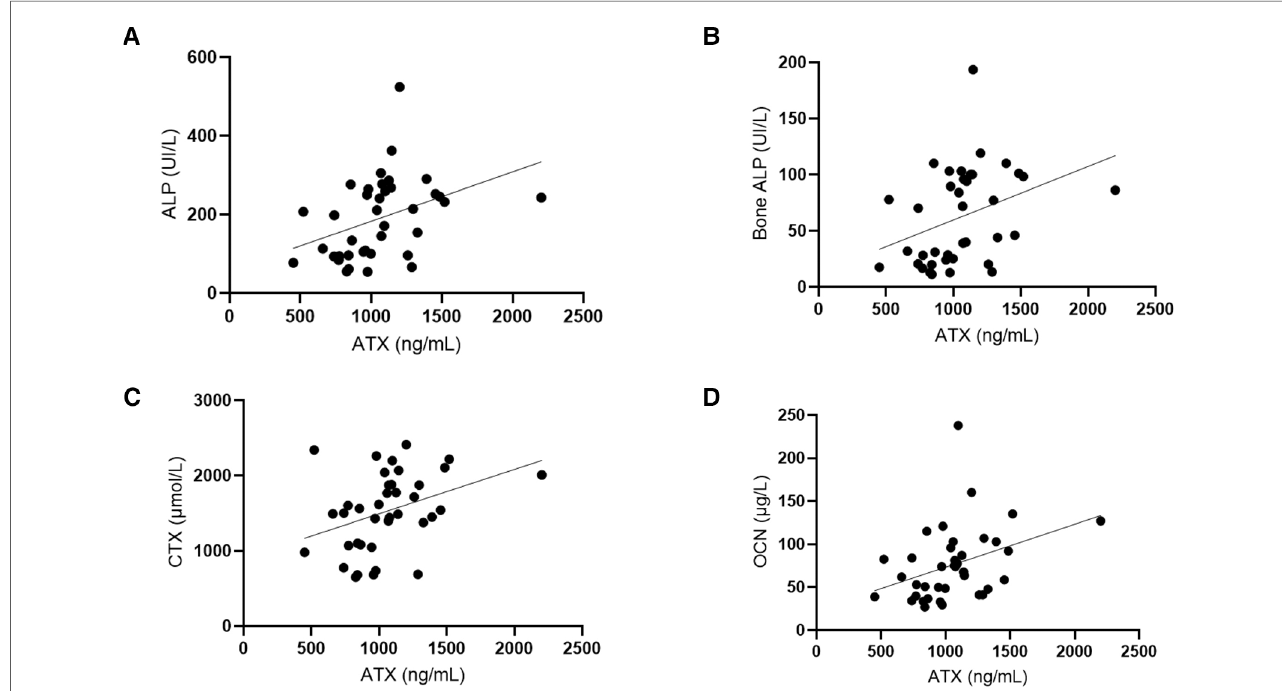
FIGURE 3 Autotaxin is positively correlated with bone turnover markers. ( A ) Correlation tests were done between ATX circulating levels (ng/ml) and ALP (UI/L, alkaline phosphatases). Spearman correlation test: r =0.051, IC95%=0.22 – 0.72, p =0.0011**. ( B ) Correlation tests were performed between ATX circulating levels (ng/ml) and bone ALP (UI/L, bone alkaline phosphatases). Spearman correlation test: r =0.47, IC95%=0.17 – 0.69, p =0.0029**. ( C ) Correlation tests were done between ATX circulating levels (ng/ml) and CTX (µmol/L, C terminal fraction of type 1 collagen). Spearman correlation test: r =0.42, IC95%=0.11 – 0.66, p =0.0086**. ( D ) Correlation tests were done between ATX circulating levels (ng/ml) and OCN (µg/L, osteocalcine). Spearman correlation test: r = 0.45, IC95%=0.15 – 0.68, p =0.0043**. Age was also correlated with these biomarkers and the Spearman correlation tests: Age and ALP: r = − 0.7944, IC95%= − 0.89 – ( − )0.63, p <0.0001. Age and BAP: r = − 0.8111, IC95%= − 0.90 – ( − )0.66, p <0.0001. Age and CTX: r = − 0.4945, IC95%= − 0.71 – ( − )0.20, p =0.0016. Age and OCN: r = − 0.7694, IC95%= − 0.88 – ( − )0.59, p